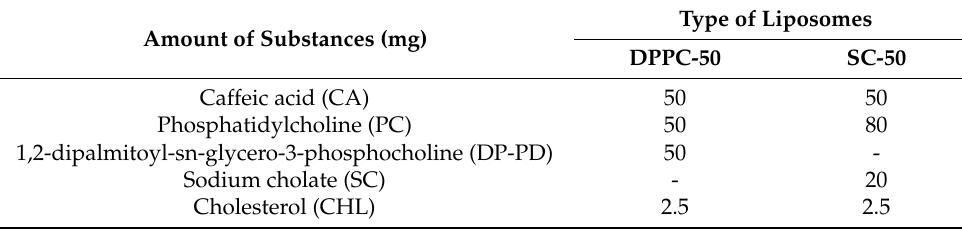
Sodium cholate (SC) Cholesterol